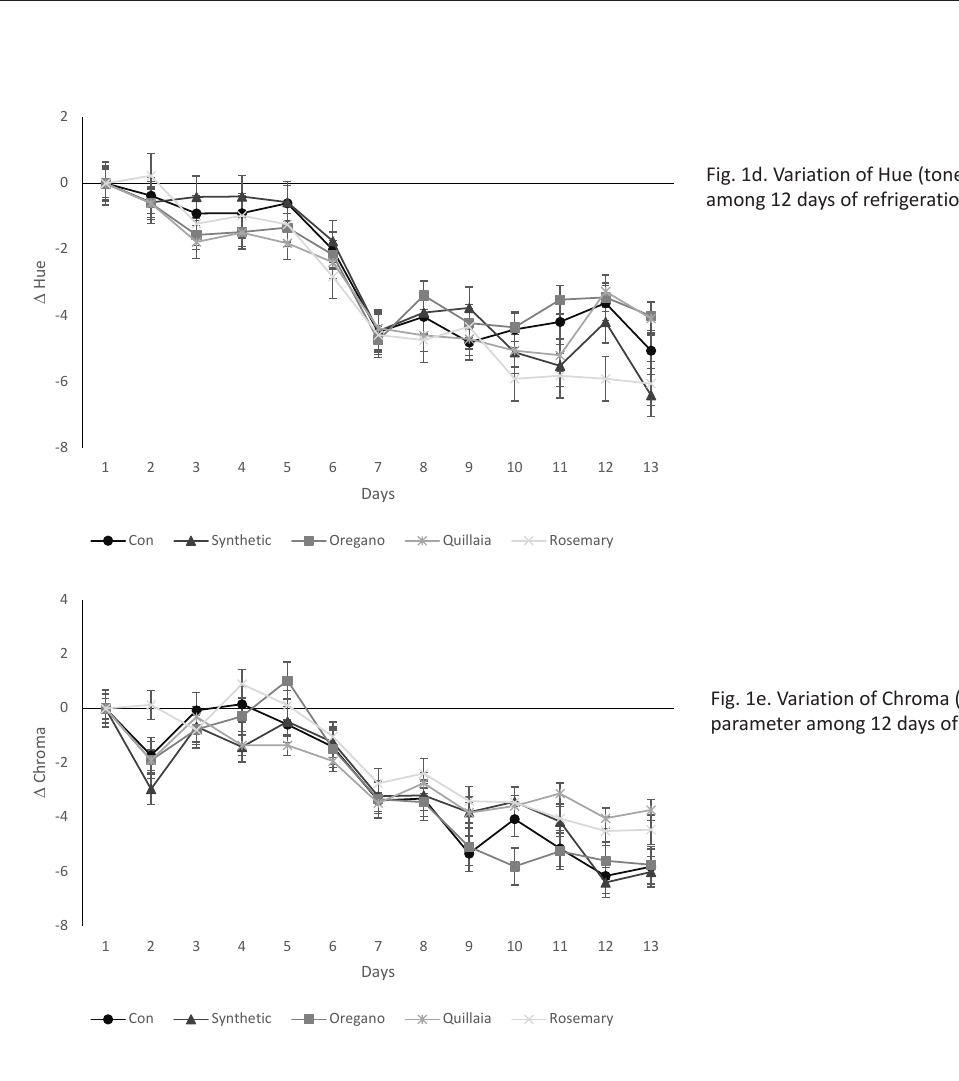
Fig. 1e. Variation of Chroma (color saturation) parameter among 12 days of refrigeration at 4